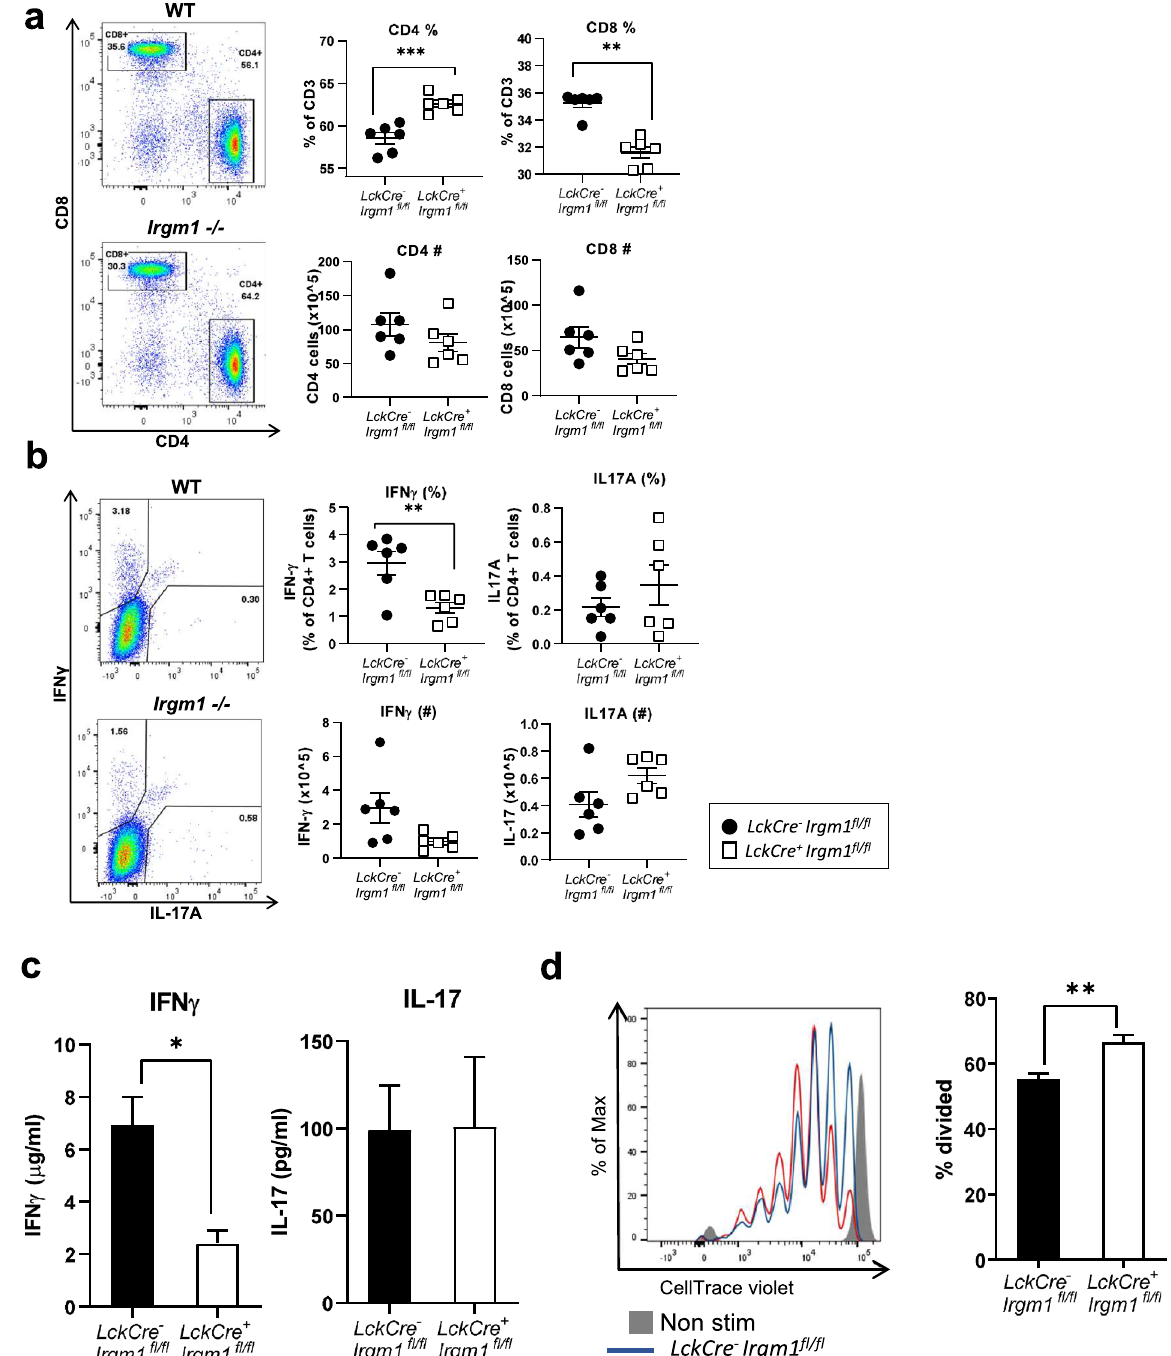
Figure 4. Changes in Th1 and Treg cell populations and function are largely due to intrinsic loss of Irgm1 expression. ( a-b ) Splenocytes were isolated from LckCre + Irgm1 fl/fl cKO mice and LckCre − Irgm1 fl/fl littermate controls, stained and analyzed by flow cytometry for CD4 and CD8 cells ( a ) , CD4 + IFNγ + and CD4 + IL-17 + ( b ) . ( c ) CD4 + T cells were isolated and activated for 48 h with plate bound anti-CD3 and anti-CD28 antibodies, after which the media was collected and IFNγ and IL-17A were measured by ELISA. ( d ) In vitro differentiated Treg cells from LckCre + Irgm1 fl/fl cKO mice and LckCre − Irgm1 fl/fl littermate controls were co-cultured for three days with WT CD8 + T cells stained with CellTrace violet. Treg suppressive capacity was analyzed by the ability to reduce proliferation of CD8 + T cells, as measured by dilution of fluorescent dye flow cytometrically (The CD8:Treg ratio for the data shown is 2:1). (a, b) data pooled from two independent experiments ( n = 6 ), (c, d) data representative of two independent experiments ( n = 3–6 ); error bars represent ± SEM. Mann Whitney test or T-test with Welch’s correction was used to compare groups depending on the normality of the distribution as judged by the Shapiro–Wilk test.* p < 0.05, ** p < 0.01, *** p <